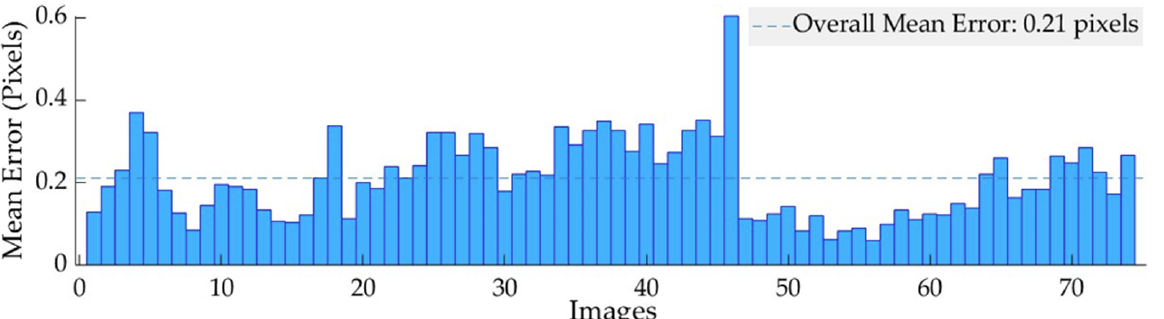
Table 3. Mean reprojection error between the distorted and undistorted image for different multi- spectral bands.